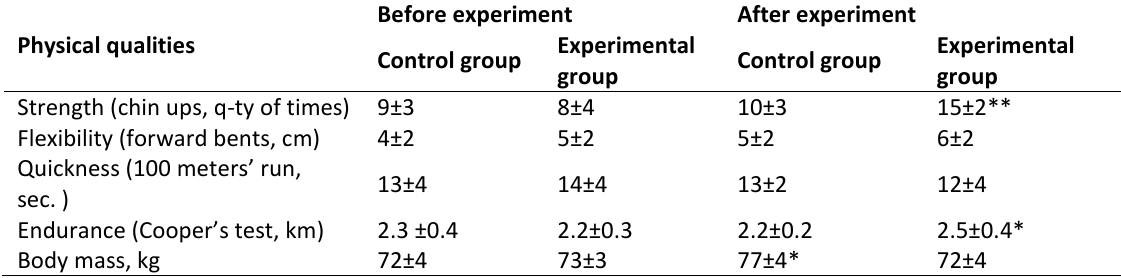
Table 1. Physical condition and physical fitness indicators of the tested boys Physical qualities